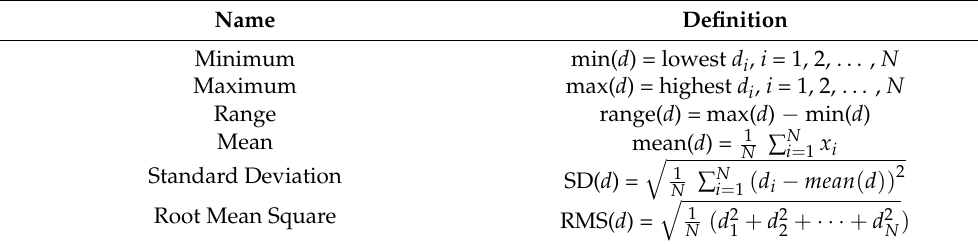
Figure 7. Acceleration signal of four repetitions of EF segmented using sliding window ( lower part ) and the proposed method ( dotted lines ). Table 1. List of features used (notation: d ∈ ( x , y , z , m ) ; N is the number of data points; i is the index).